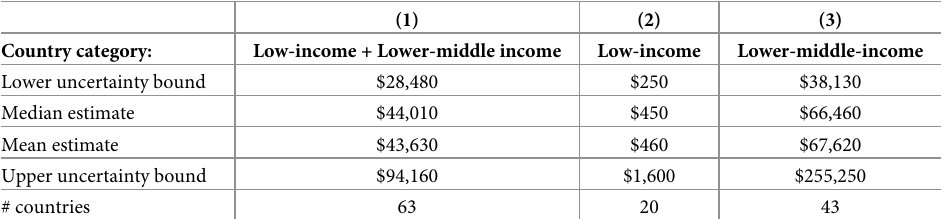
Table 4. Estimations of poverty reduction benchmarks: Cost associated with averting one poverty case, across low-income countries and lower-middle-income countries.